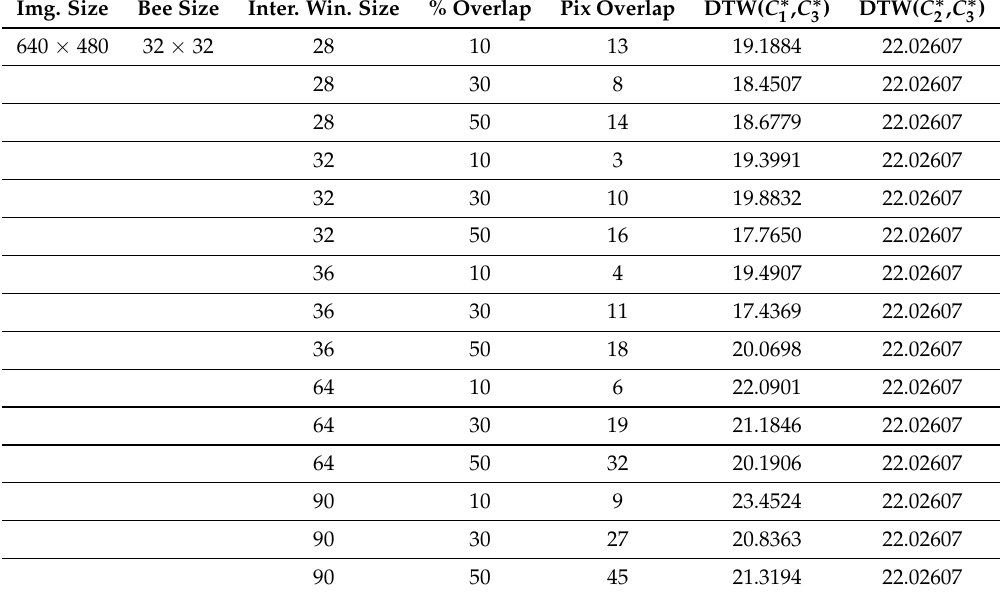
Table 4. DTW values for HT _ Vid . mp 4 with image size of 640 × 480; C ∗ and C ∗ is Human Count (ground truth). 3